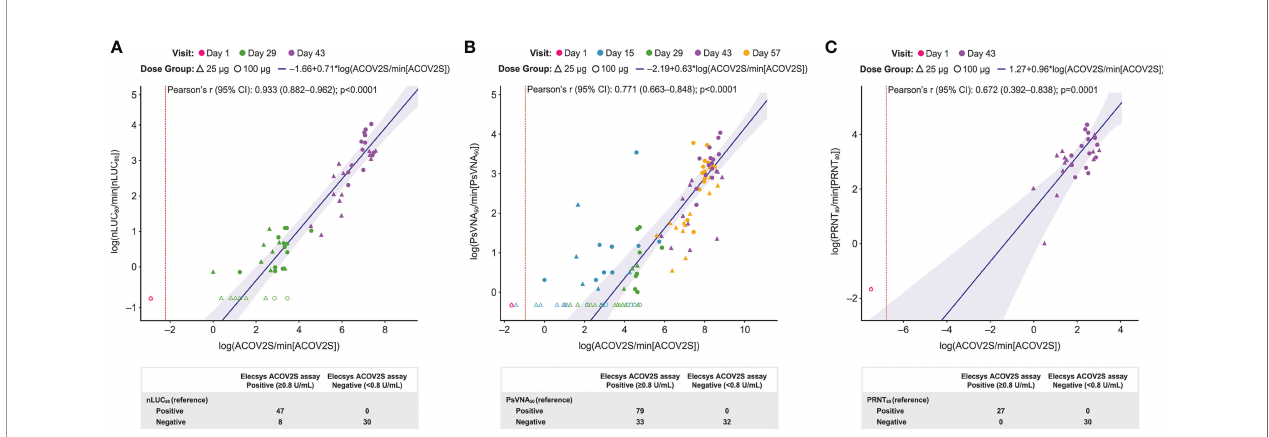
FIGURE 4 | Comparison of ACOV2S and neutralization assays. Passing – Bablok regression fi t (log-scale) of ACOV2S with nLUC 80 is shown in (A) , PsVNA 50 in (B) and PRNT 80 in (C) . Red dotted line shows ACOV2S reactivity cut-off. The shaded area represents the 95% con fi dence interval for the fi tted curve. Dots or crosses show individual sample readouts. Filled dots or triangles represent samples within the measuring range for both ACOV2S and respective comparator assay. Overlaid table shows the qualitative agreement between Elecsys ACOV2S and comparator